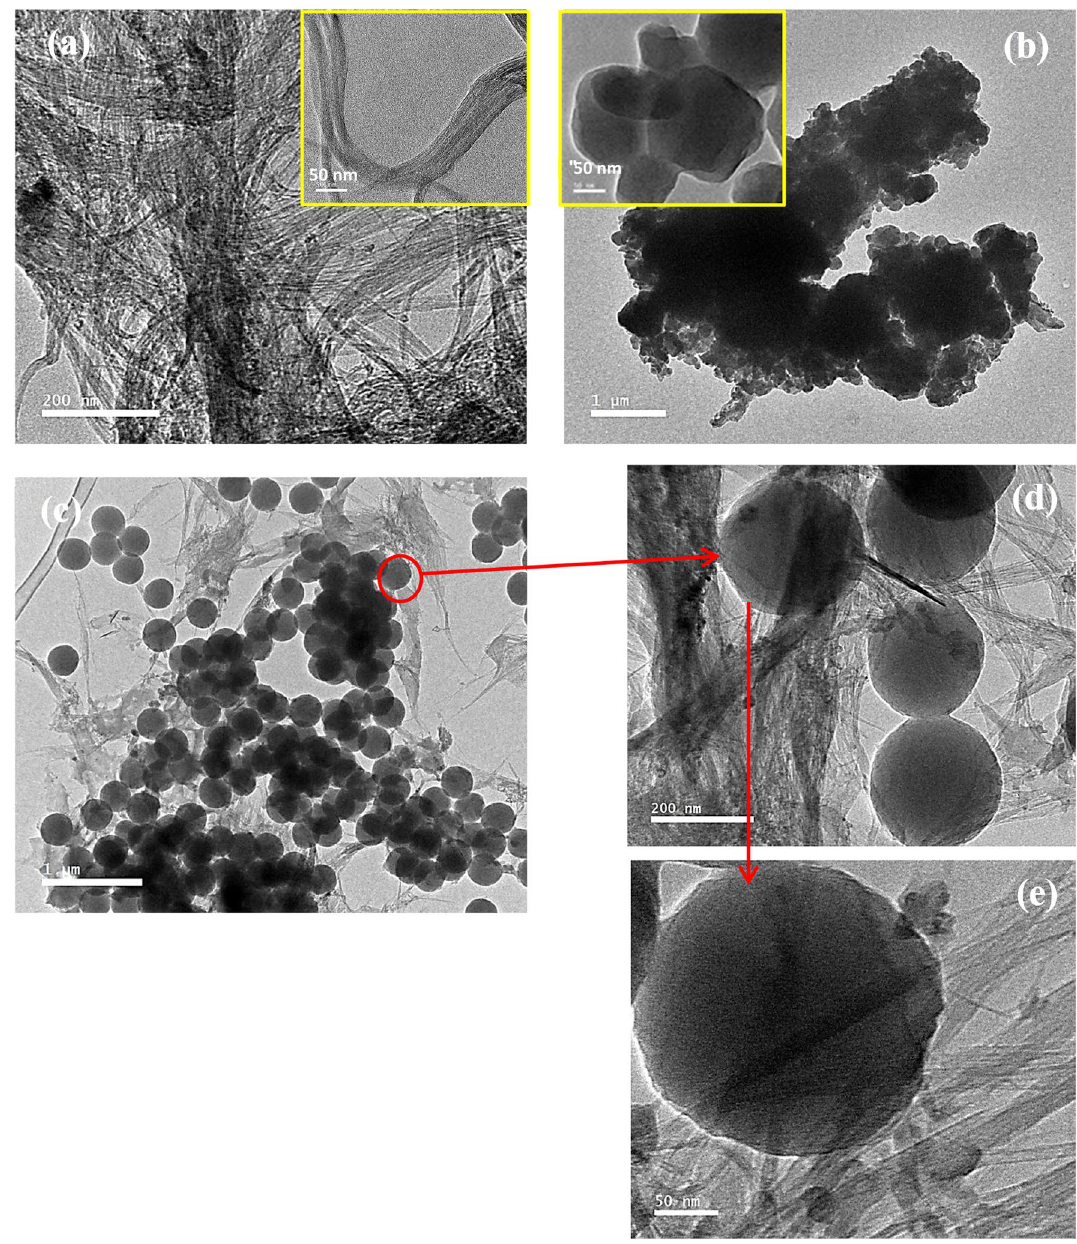
Figure 4. TEM images of: ( a ) purified SWCNTs, ( b ) pure P3HT, the inset image is the sample at higher magnification. ( c–e ) P3HT/50% SWCNTs at deferent